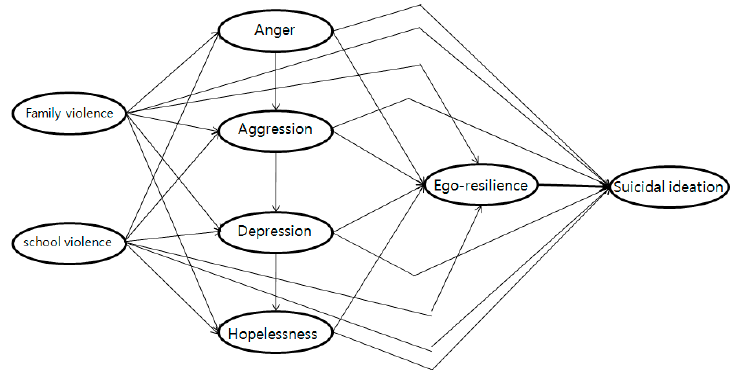
Figure 1. Conceptual framework.